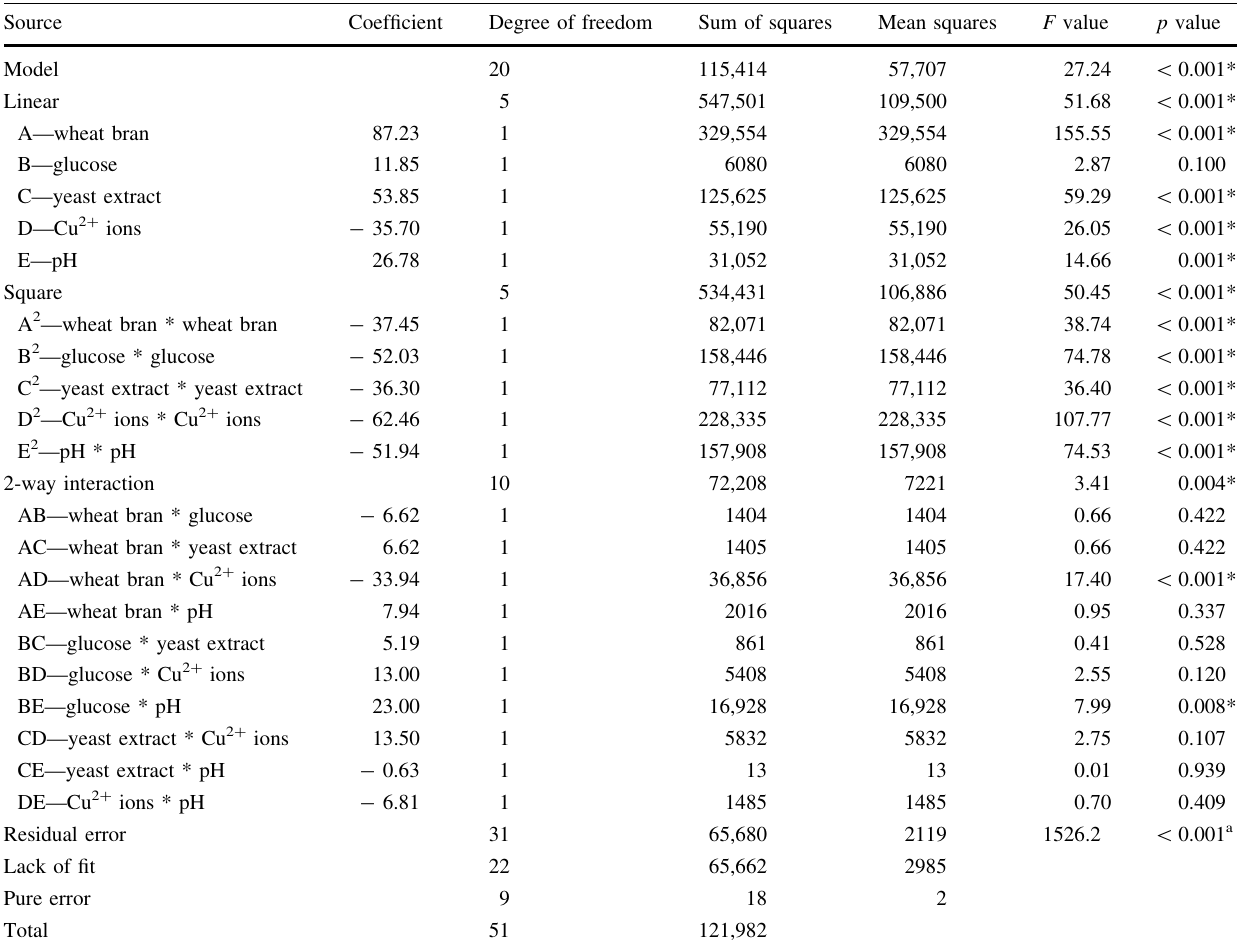
Table 5 Analysis of variance for response surface quadratic model for laccase